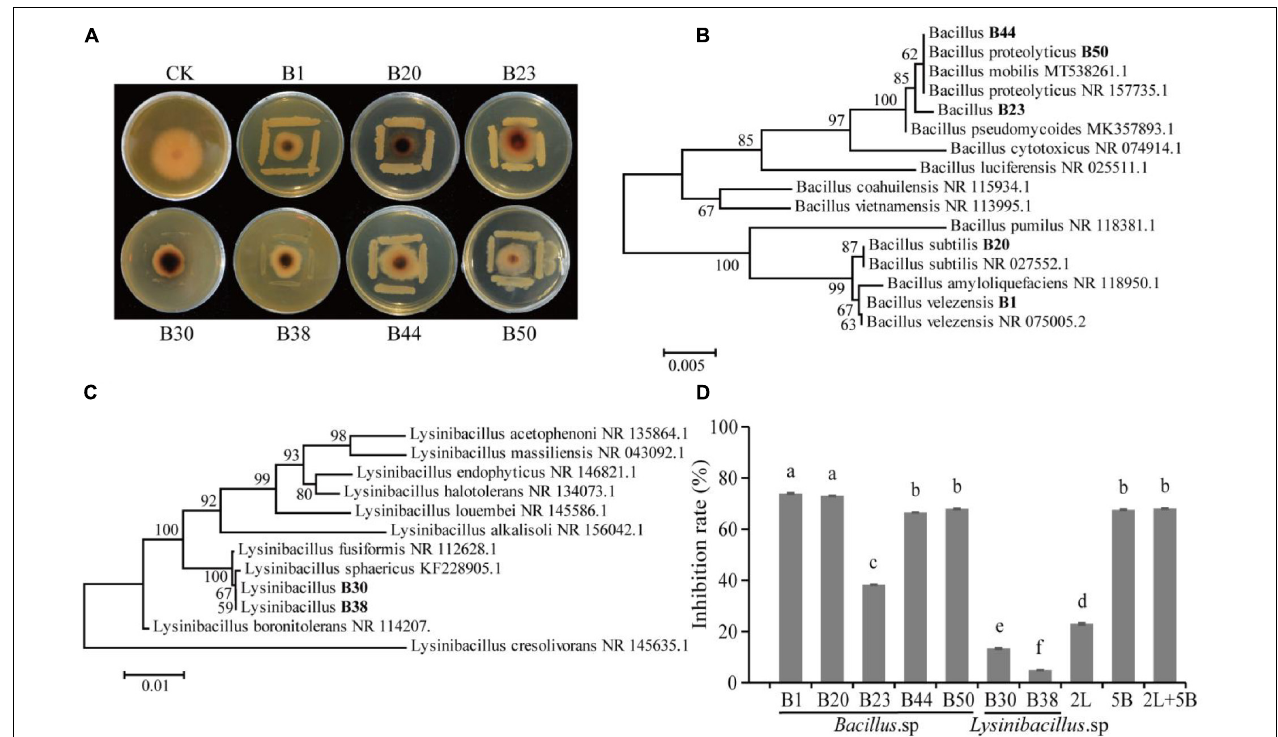
FIGURE 4 | Isolation and identification of antagonistic microbes. (A) Antagonistic activity of isolates against F. oxysporum ; (B) hierarchical clustering of Bacillus spp.; (C) hierarchical clustering of Lysinibacillus spp.; (D) antifungal effect of antagonistic strains alone or in combination against F. oxysporum (2L, equal proportion combination of two Lysinibacillus isolates; 5B, equal proportion combination of five Bacillus isolates; 2L + 5B, equal proportion combination of seven bacterial isolates). Values in the bar plot are expressed as the mean with standard deviation ( n = 3). Different letters on the bars indicate statistically significant differences ( P < 0.05) based on Duncan’s